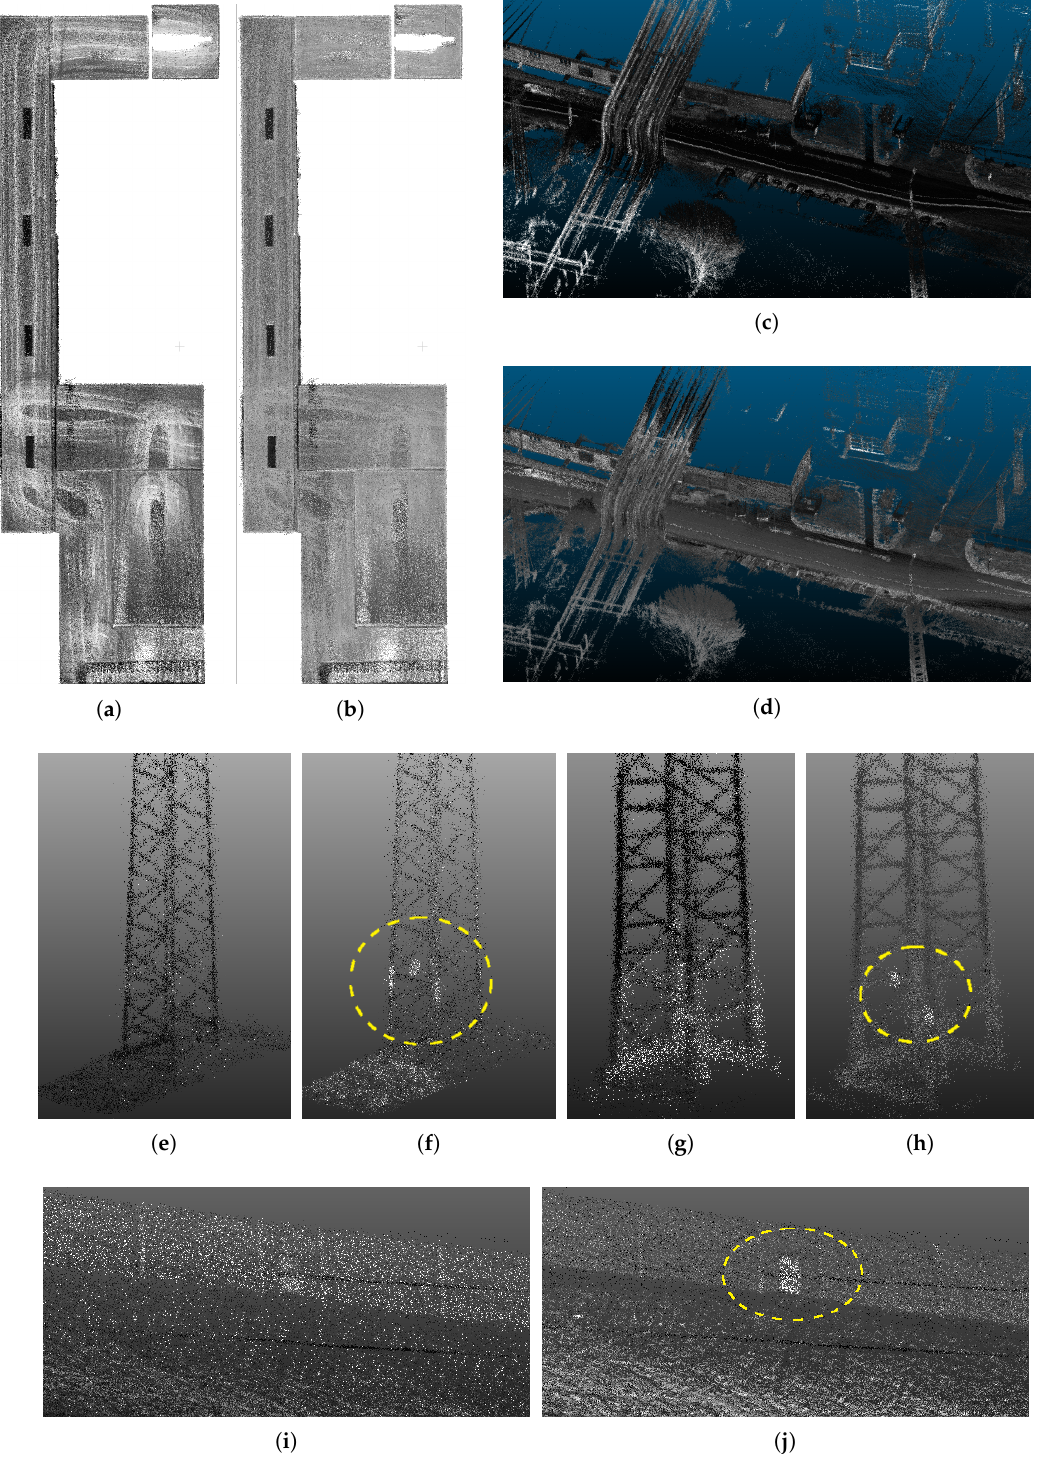
Figure 19. Results of 3D reconstruction without ( a , c , e , g , i ) and with ( b , d , f , h , j ) the normalization of laser intensities. One can observe more consistent intensities for solid color ceiling ( b ) reducing the artifacts of trajectory, while preserving the contrast with ceiling lights. Besides the consistency, normalization of intensities reduces the noise ( d ). The most significant improvement is the visibility of important objects e.g., markers at the electrical towers ( f , h ) or emergency exit doors ( j ) at the highway wall. All these objects can not be found in the original point clouds( e , g , i